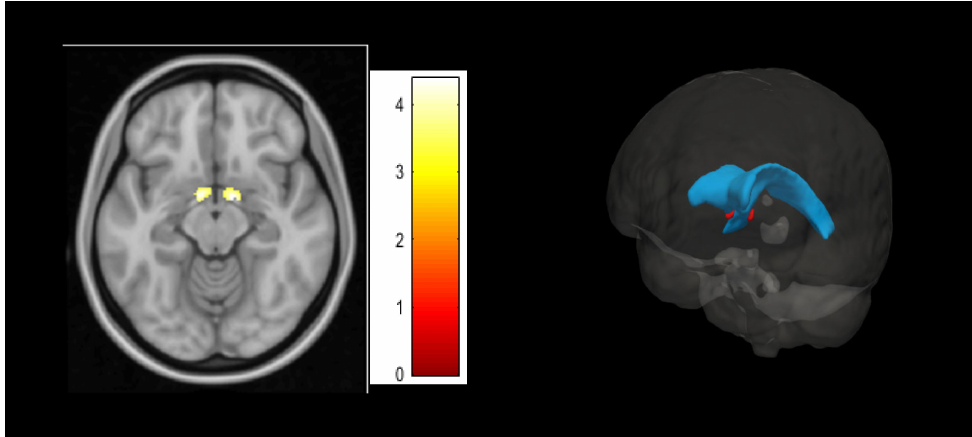
Figure 2. Left hand: Psychological Inflexibility in Pain Scale (PIPS)-related brain cluster (Montreal Neurological Institute (MNI) coordinates: x = 11, y = –2, z = –12 (right) and x = –8, y = 0, z = –11 (left)) in the bed nucleus of the stria terminalis (BNST). Right hand: Anatomical illustration of the BNST (red) and the lateral ventricles